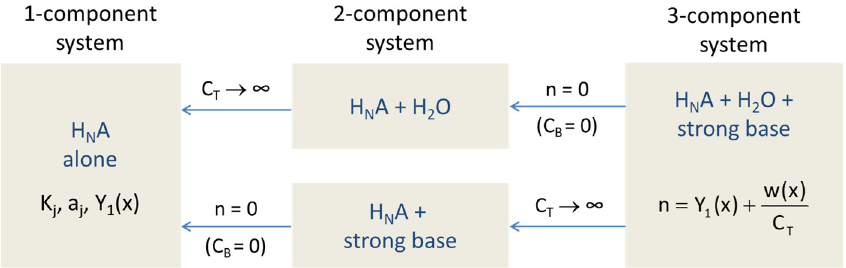
Figure 2. Relationships between 1-, 2-, and 3-component systems.